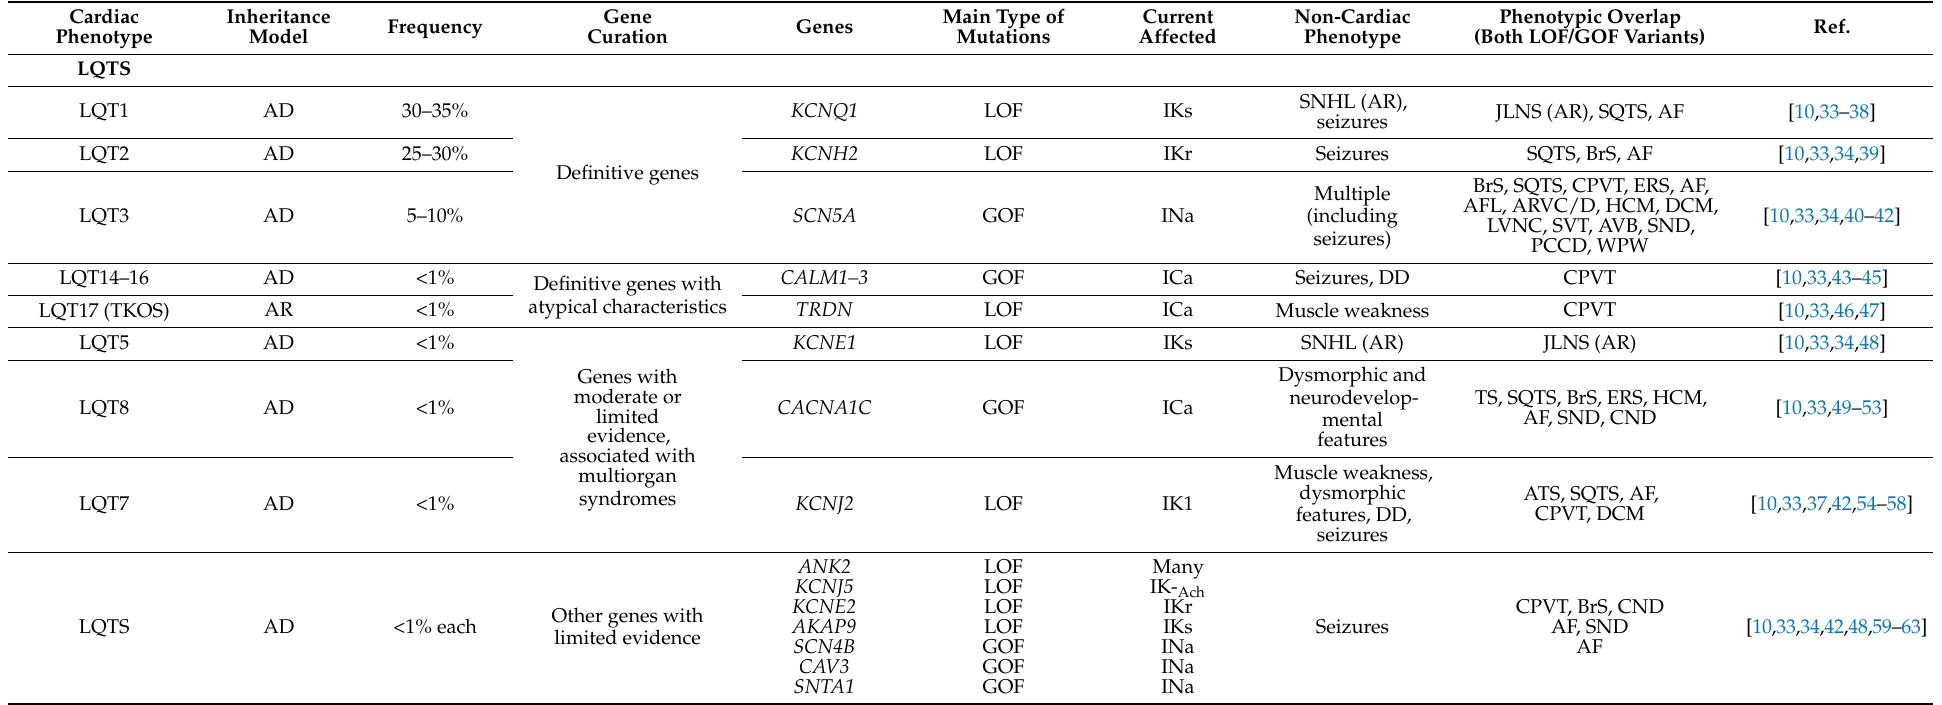
Table 1. Genotype-phenotype IASs correlation. Based on ClinGen [13]. Adapted from Nakajima, et al. [33]. ACM: Arrhythmogenic cardiomyopathy; AE3: Anion exchanger; AF: Atrial fibrillation; AFL: Atrial flutter; AR: autosomal recessive; ATS: Andersen-Tawil syndrome; AVB: atrioventricular block; BrS: Brugada syndrome; CDSP: Systemic primary carnitine deficiency; CPVT: catecholaminergic polymorphic ventricular tachycardia; CND: complex neurodevelopmental disorder; CRDS: Ca 2+ -release deficiency syndrome; DCM: Dilated cardiomyopathy; DD: developmental delay; DM: diabetes mellitus; ERS: Early repolarization syndrome; HCM: cardiomyopathy; Hypertrophic GOF: gain-of-function; ICa: Voltage-gated calcium currents; Ih: Hyperpolarization-activated non-selective cation channels/currents; IK: Delayed rectifier potassium currents; IK- Ach : Acetylcholine-activated inward rectifier potassium currents; IK- ATP : ATP-sensitive inward rectifier potassium currents; IKr: Rapidly activating IK; IKs: Slowly activating IK; IK1: Inward rectifier potassium currents; INa: Voltage-gated sodium currents; Ito: Transient